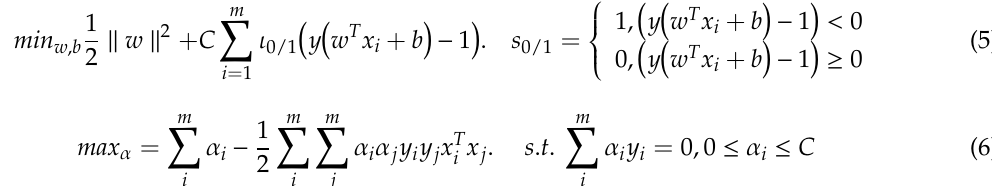
Table 5. Relief ‐ F ‐ SVM kernel function classification accuracy.